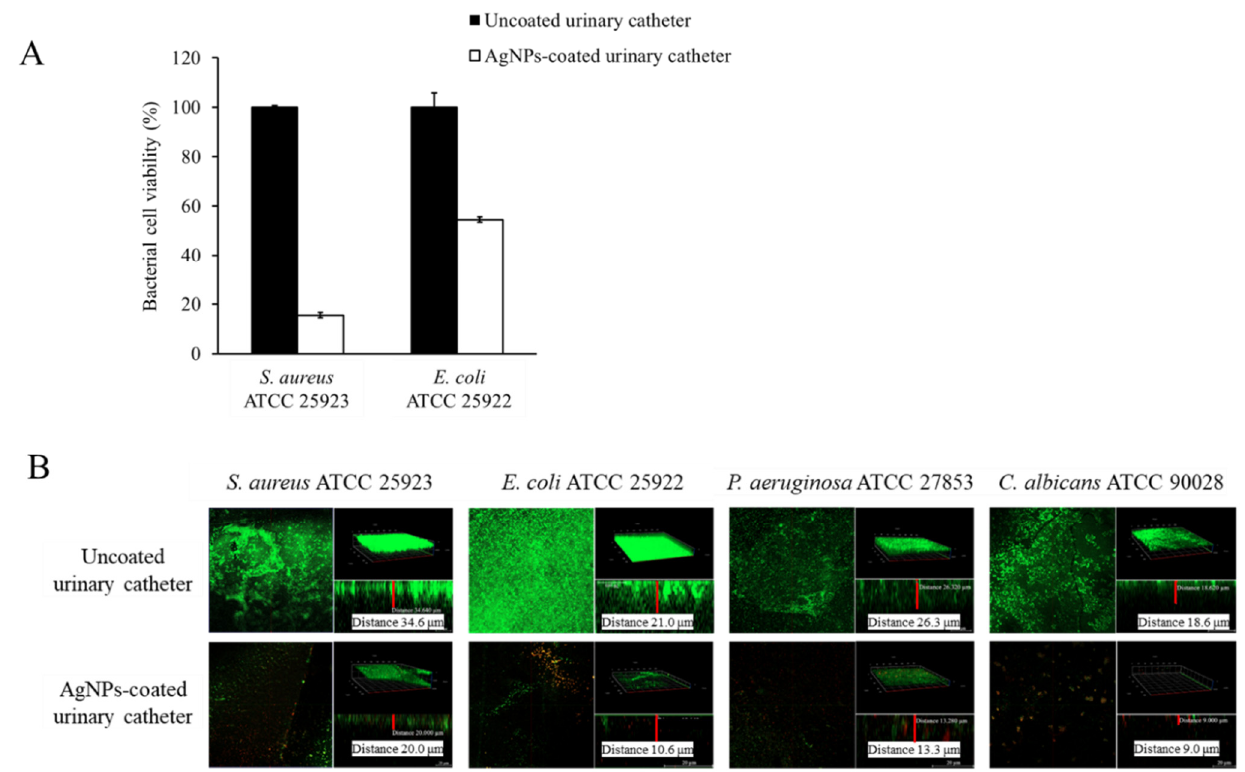
Figure 5. Effects of AgNPs-coated urinary catheter on biofilm formation of Staphylococcus aureus ATCC 25923 and Escherichia coli ATCC 25922 following incubation for 24 h. ( A ) Cell viability in biofilms was determined using MTT assay. The values indicate mean ± SD from three independent experiments performed in triplicate, p < 0.05. ( B ) Biofilms were observed under confocal laser scanning microscopy after staining with LIVE/DEAD ® viability fluorescent dye. A representative photograph was from one of the three independent examinations.